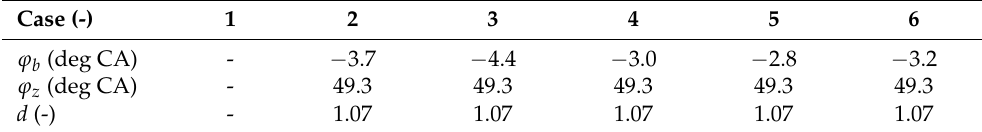
Table 10. The Wiebe parameters according to the SL model in fuel sharing mode.